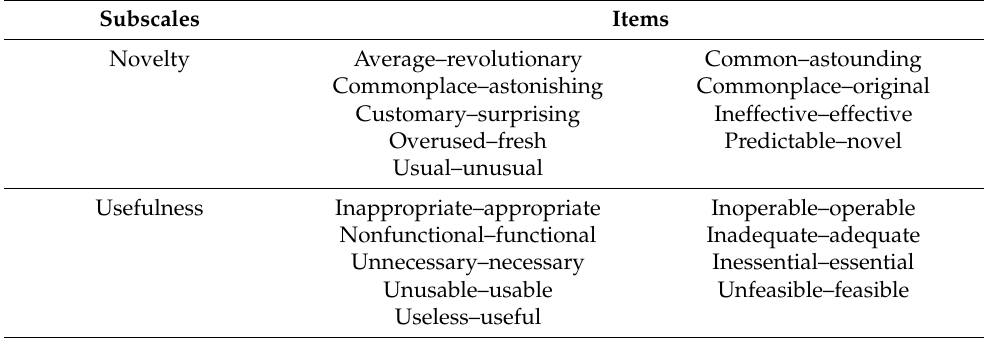
Table 2. Eighteen criteria of the CPSS in this paper (adapted from Chulvi et al. (2012), Han (2018), and Yin et al.